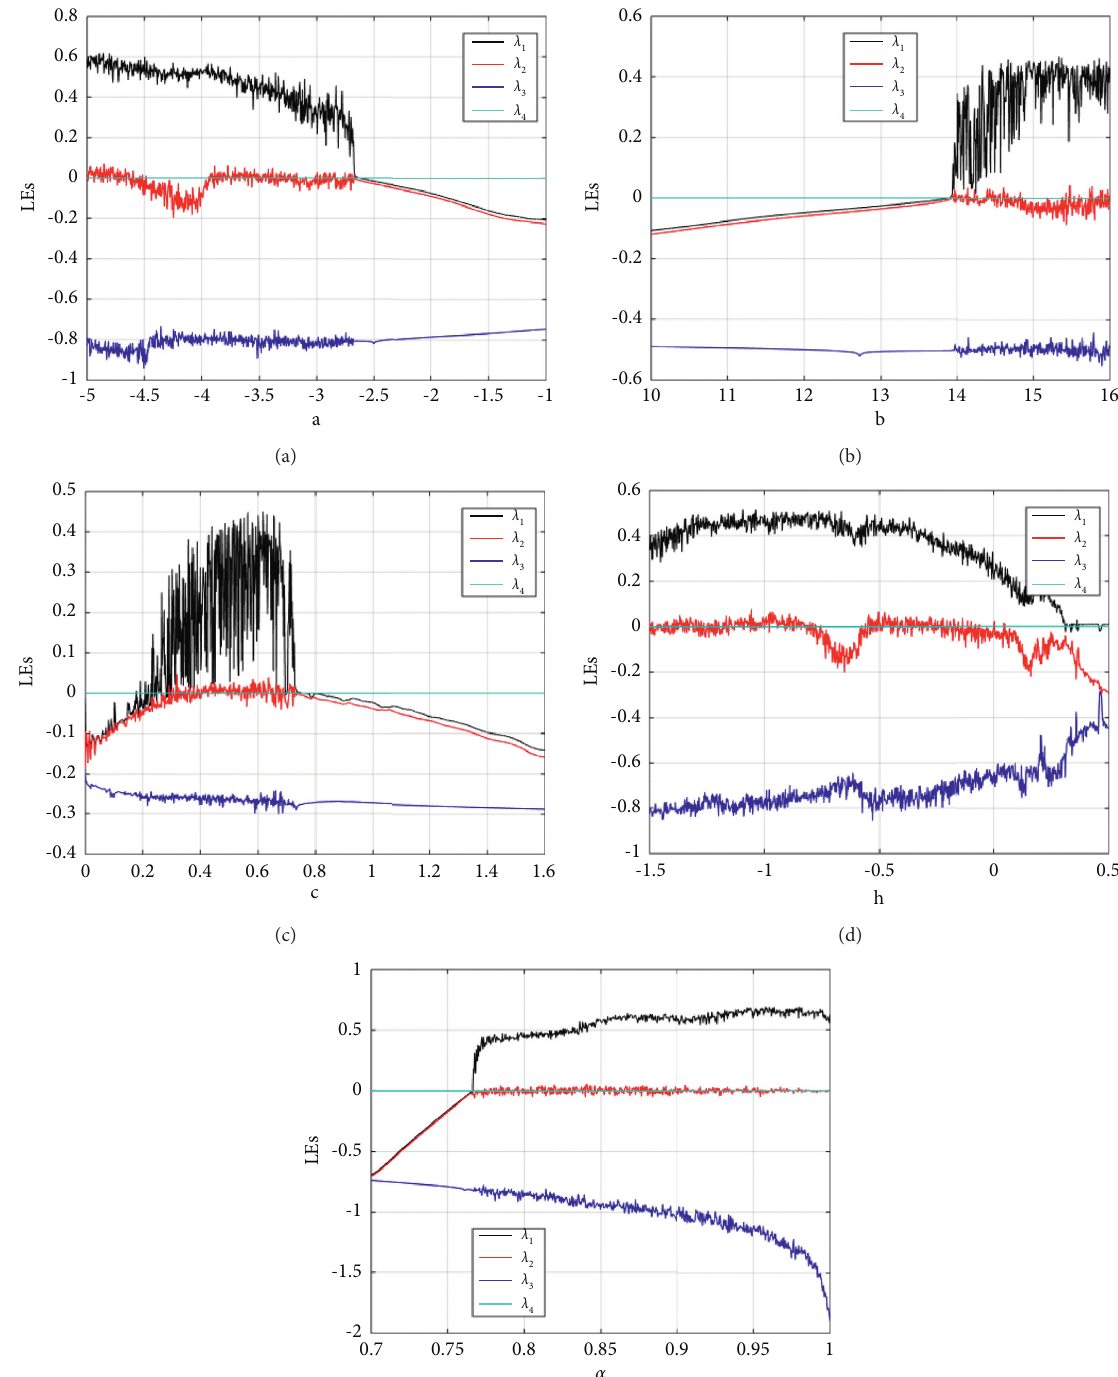
Figure 6: Lyapunov spectrum of system (4) with fixing the parameter values according to the set A and setting α � 0 . 77 α � 0 . 77, (b) except varying the parameter b and setting α � 0 . 77, (c) except varying the parameter c and setting α � 0 . 77, (d) except varying the parameter h and setting α � 0 . 77, and (e) varying α